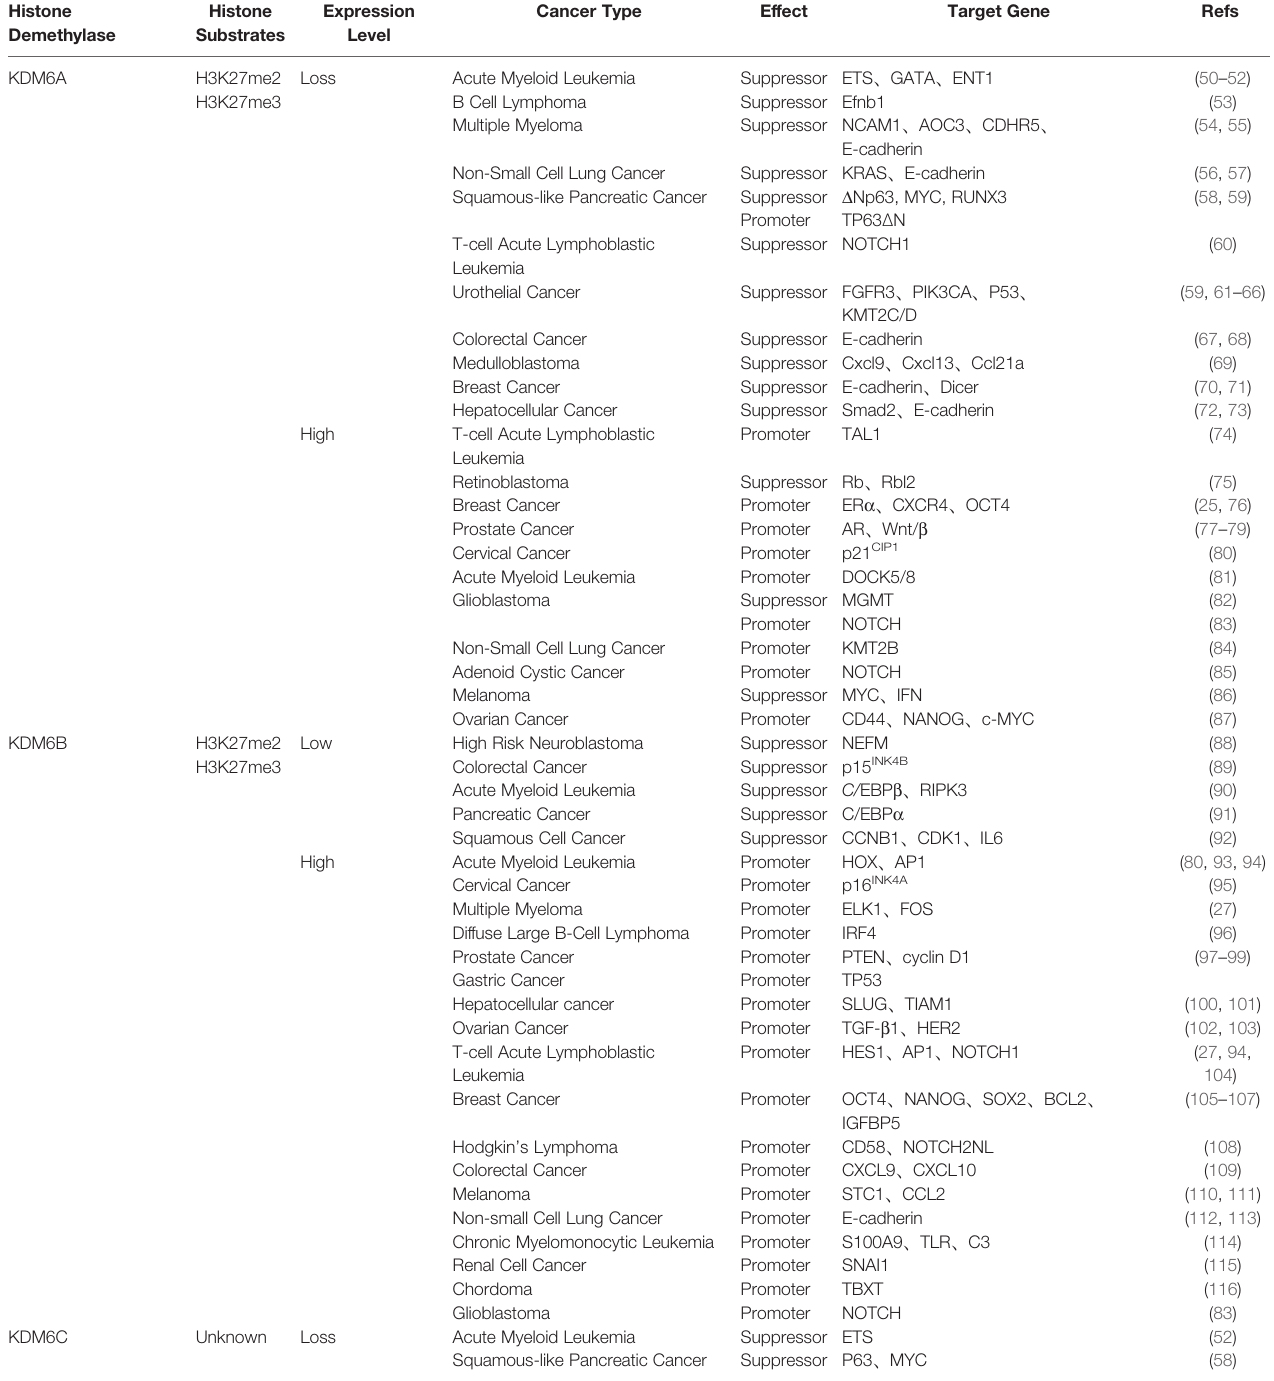
TABLE 1 | Histone substrates, expression levels, effects and target genes of KDM6 in various